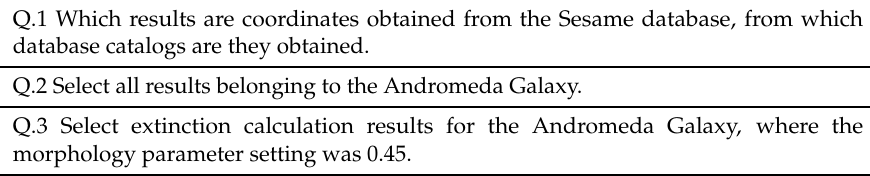
Table 2. Three Provenance Queries for Reporting